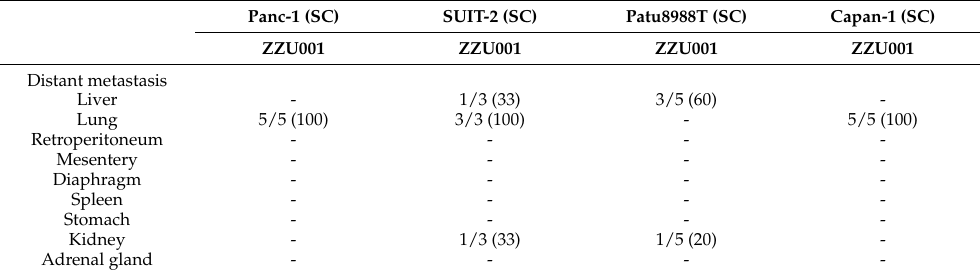
Figure 3. (From [38], with permission). H&E staining of a lung metastasis at 22 d, 29 d, 36 d after subcutaneous injection of MIA-PaCa-2 cells in ZZU001 hamsters and B-NDG mice. Scale bars = 100 µm. Table 2. (From [38], with permission). Metastasized organs and metastasis frequency by four independent human pancreatic cancer cell lines transplanted subcutaneously (SC) in hamsters and mice. and Panc-1 (SC) SUIT-2 (SC)